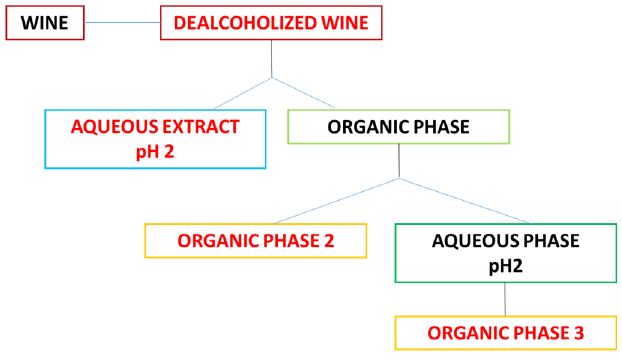
Figure 1. Extraction phases for red wine fractions.